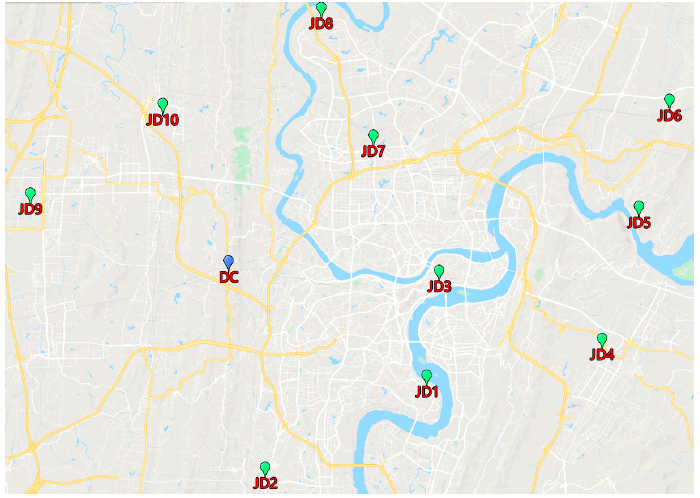
Figure 2. The distribution map of Jingdong (JD) distribution center and customer nodes.